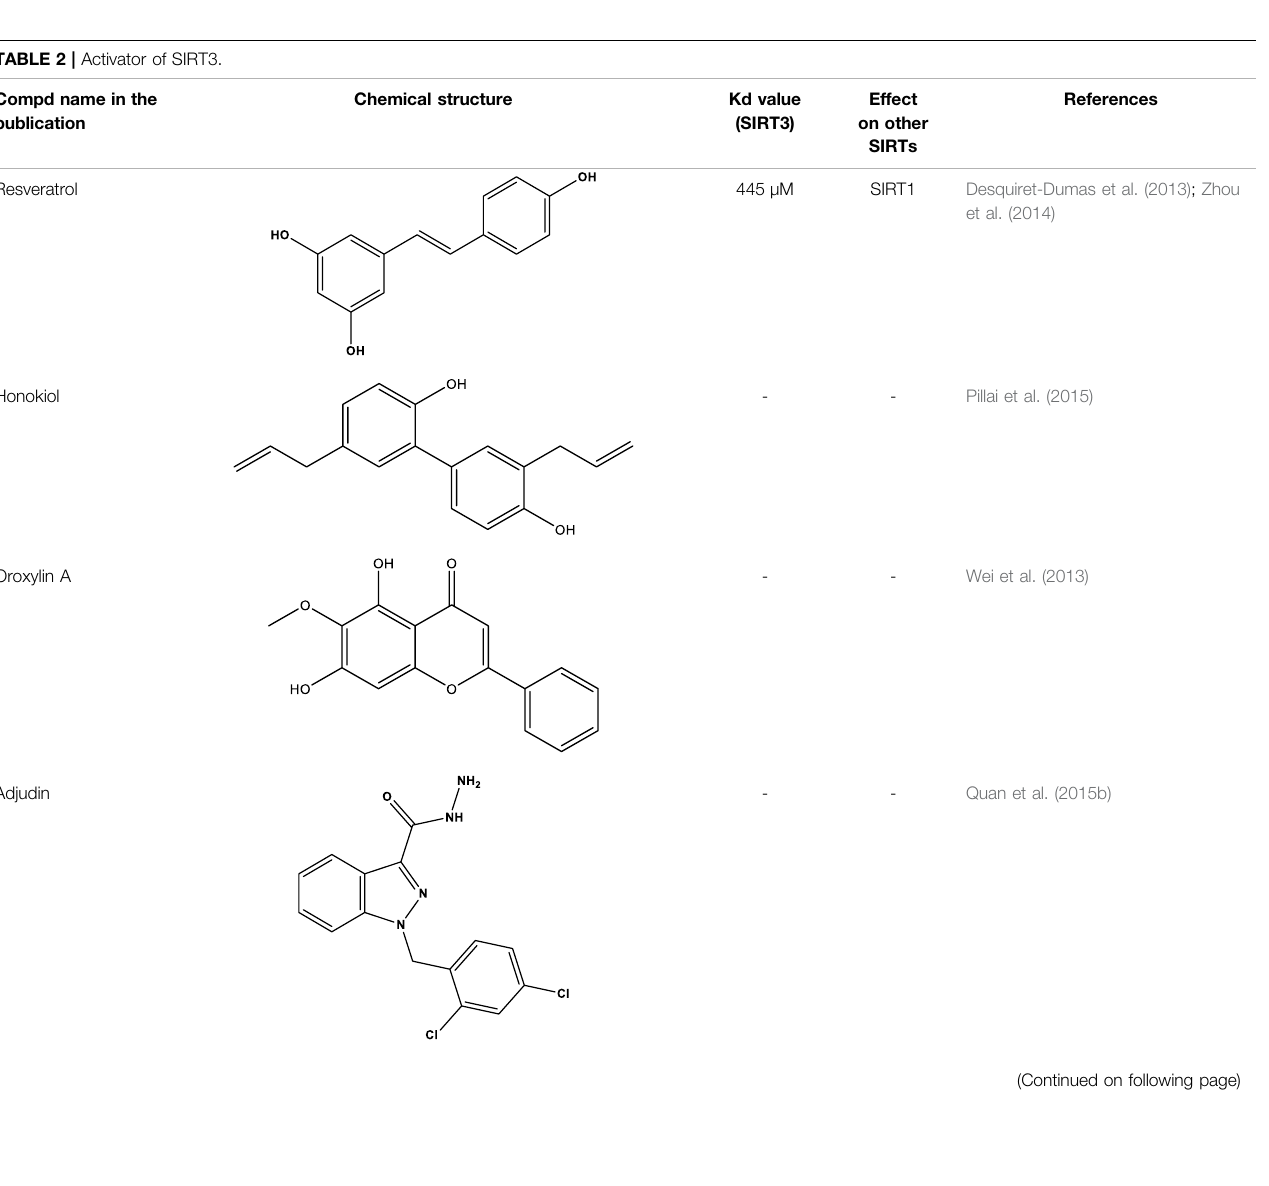
TABLE 2 | Activator of